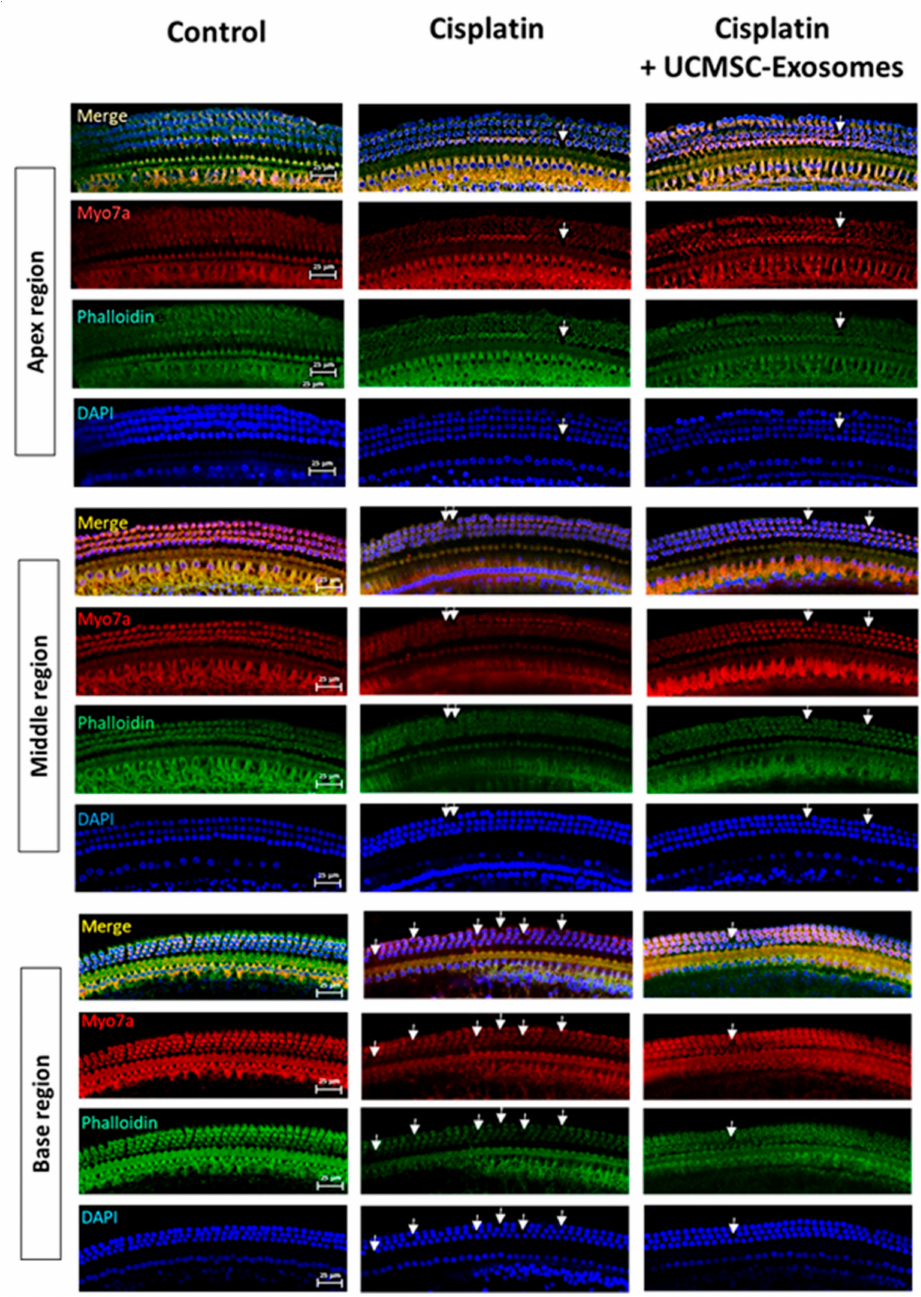
Figure 3. Immunohistochemical staining analyses. Representative results of immunohistochemical staining of the nucleus (DAPI, blue), hair cells (HCs, Myo7A, red), and cytoskeleton (phalloidin staining, green) at the regions of the apex, middle, and base of the cochlear tissues in each group of mice are shown. Scale bar = 25 µ m. The loss of OHCs in the cochlear tissues is indicated by